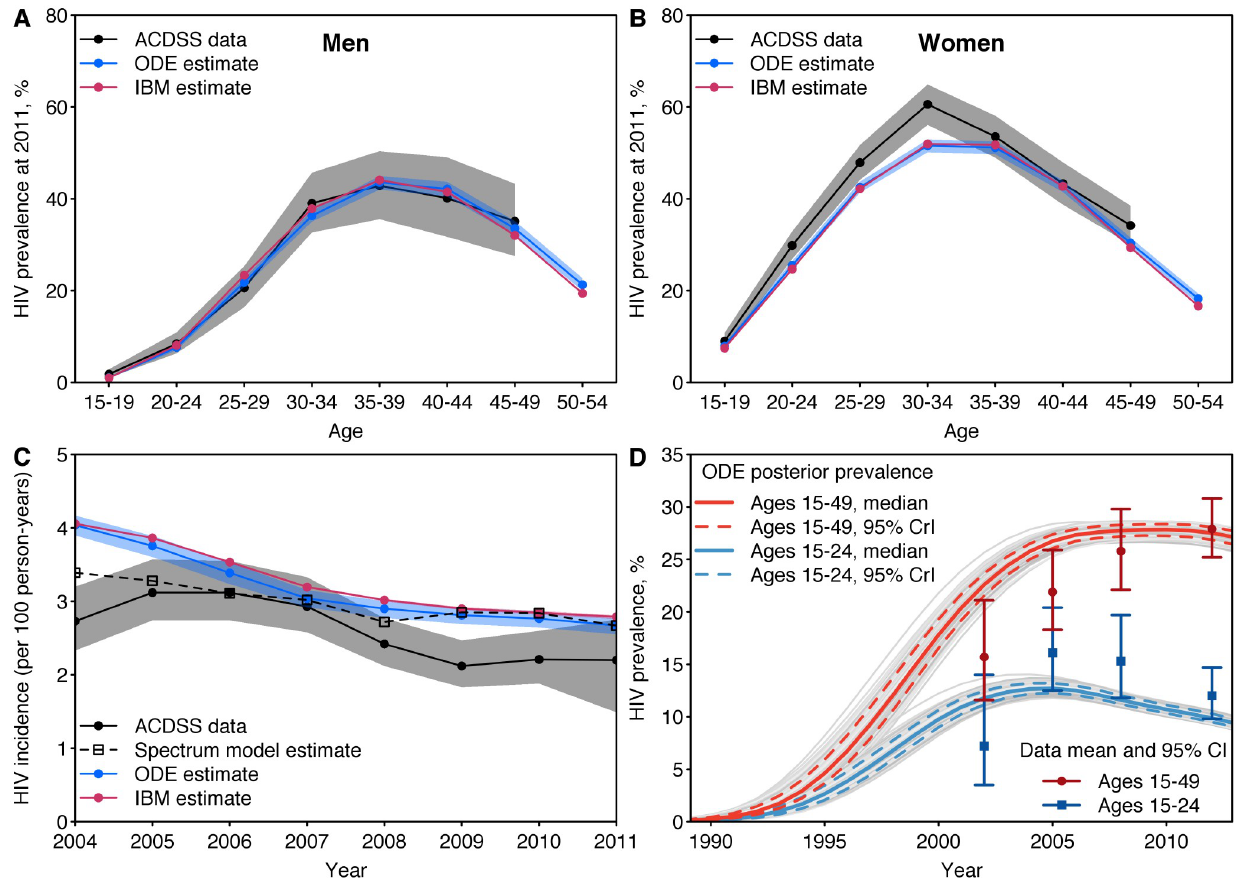
Fig 2. Calibration of the deterministic model and the stochastic individual-based model. Model calibration to HIV prevalence among (A) women and (B) men by age. Error bars show 95% confidence intervals for data and 95% credible intervals for the IBM model (imperceptible because narrow) and ODE model (posterior) estimates. C: Model calibration to HIV incidence in the ACDSS and comparison to the UNAIDS’ Spectrum model [40]. D: Model validation against HIV prevalence in KwaZulu-Natal among adults aged 15–24 and 15–49 from the four South African national household surveys [7]. Abbreviations: ODE, ordinary differential equation; IBM, individual based model; ACDSS, Africa Centre Demographic Surveillance Site; CrI, credible interval.